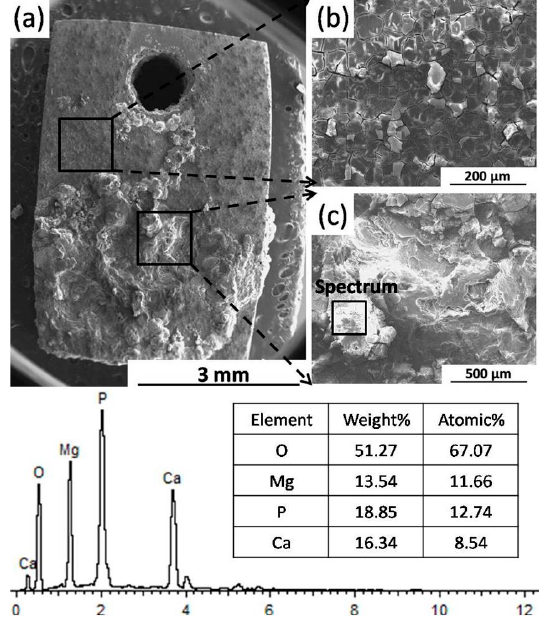
Figure 6. Surface morphology of the BM specimen (at different magnification) after immersion for one day, and the corresponding EDS spot analysis. (With corrosion products).